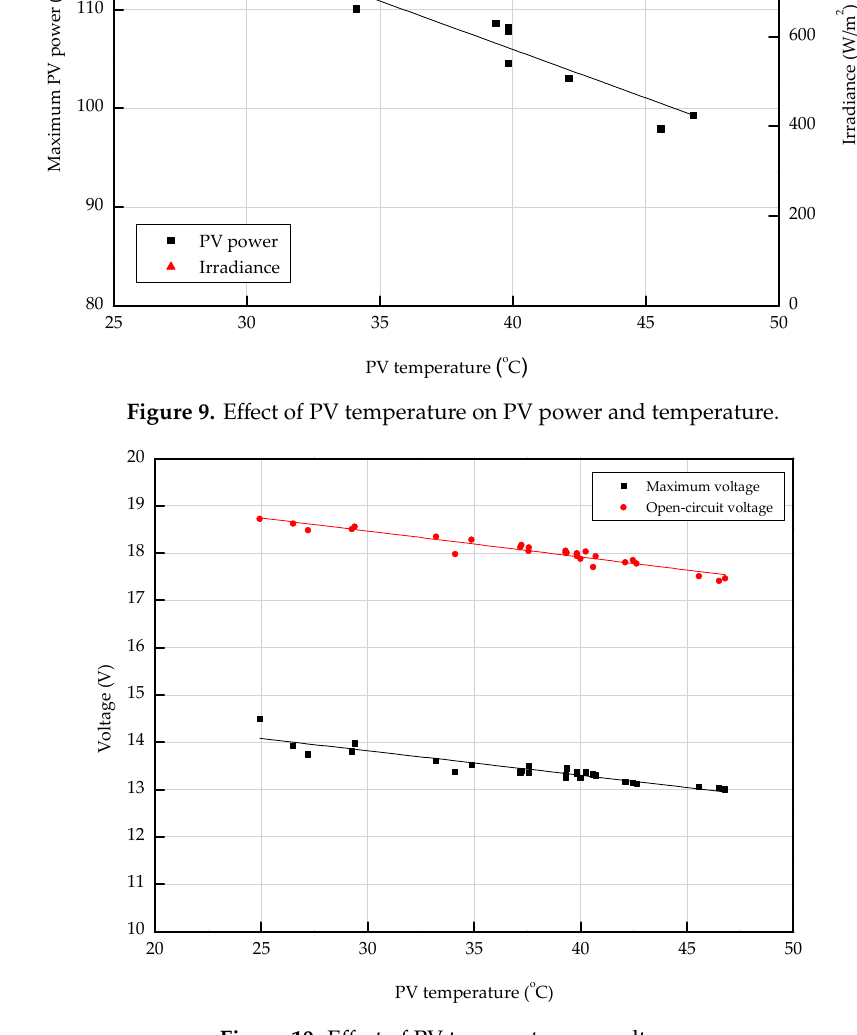
Figure 10. E ff ect of PV temperature on Figure 10. Effect of PV temperature on voltage. Figure 10. Effect of PV temperature on voltage.